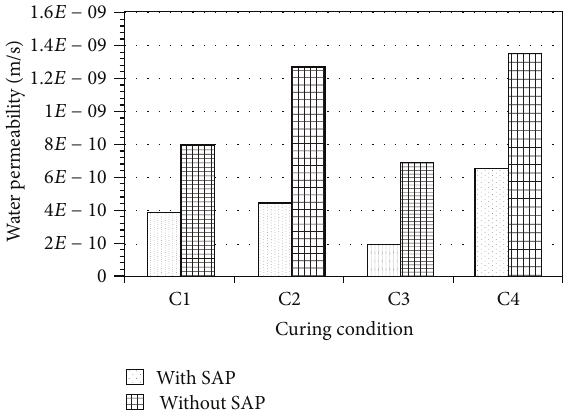
Figure 8: Test results on water permeability of different type of concrete.